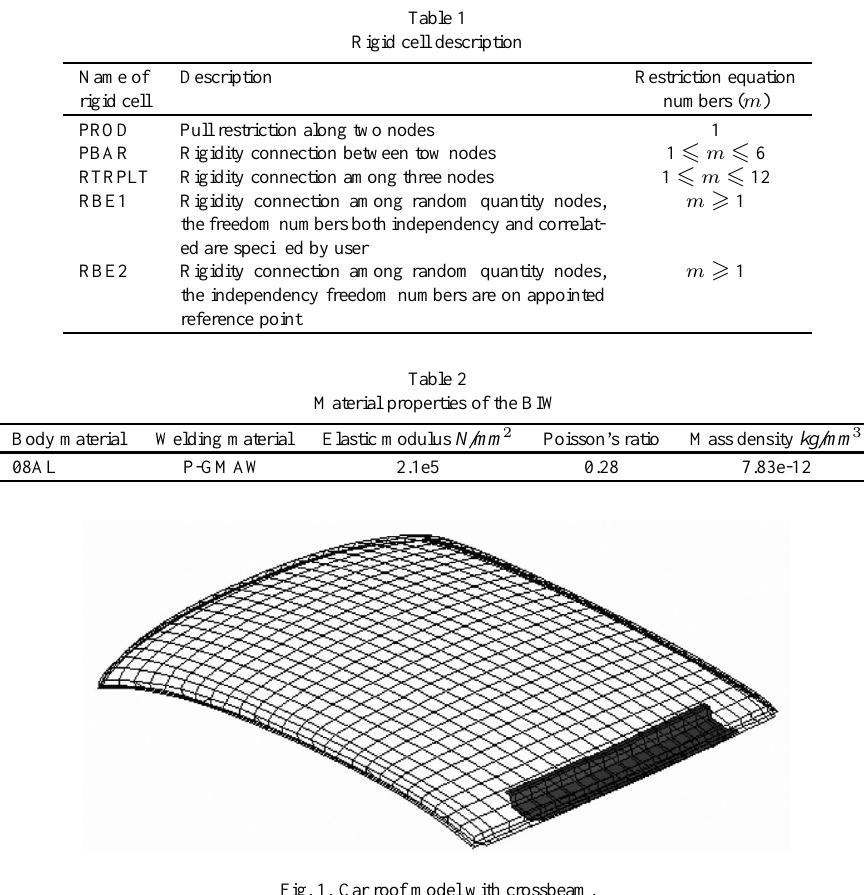
Fig. 1. Car roof model with